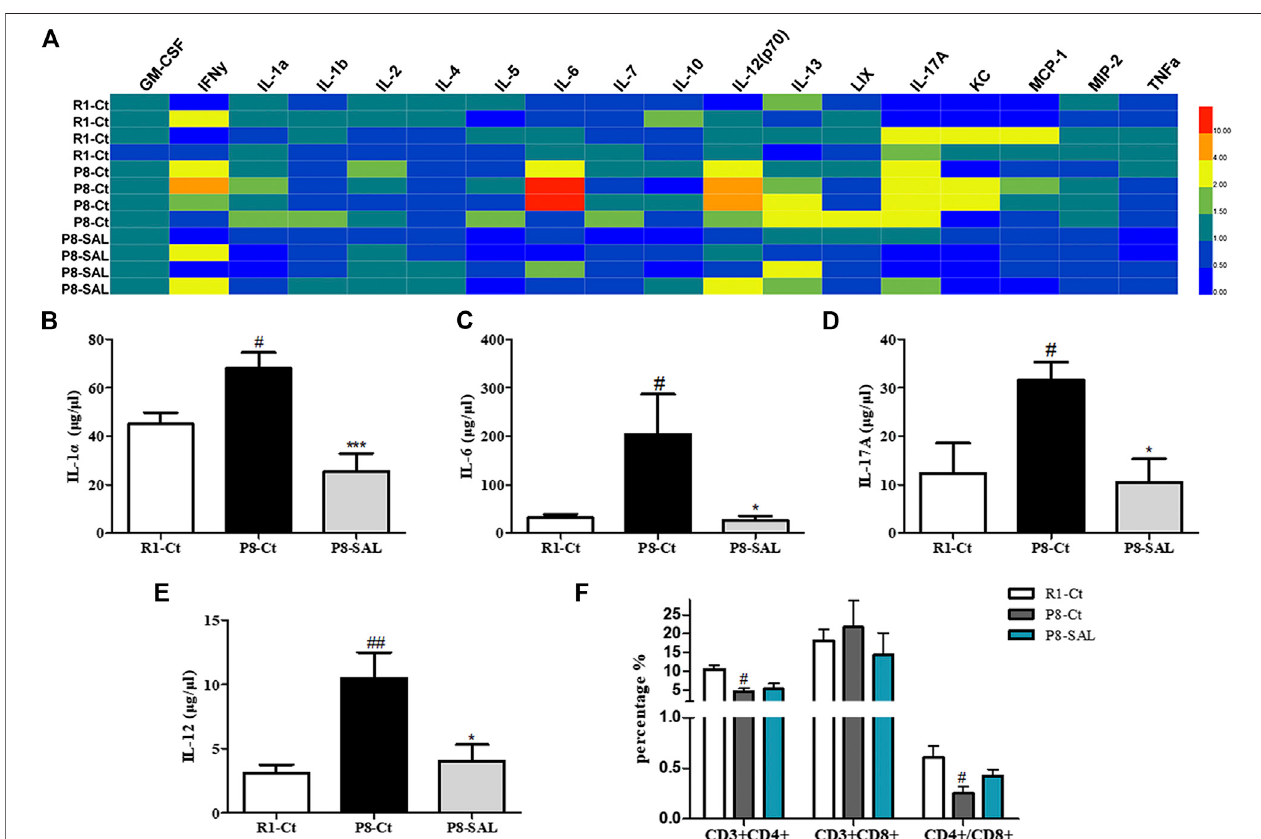
FIGURE 7 | Effect of SAL on peripheral in fl ammation in SAMP8 mice. (A) Heatmap of 18 serum cytokine/chemokine levels, as detected by the Mouse High Sensitivity T Cell Magnetic Bead Panel. Quantitation of (B) IL-1 α , (C) IL-6, (D) IL-12 and (E) IL-17A levels. (F) The spleen index was calculated as spleen weight (G) / mouse weight (G) . (G) Flow cytometry results, including the proportions of CD3 + CD4 + and CD3 + CD8 + cells and the ratio of CD4 + /CD8 + spleen lymphocytes. The bars represent the mean ± SE of each group ( n (cid:2) 3). # p < 0.05, and ## p < 0.01 versus the R1-Ct group and * p < 0.05 and *** p < 0.001 versus the P8-Ct group.